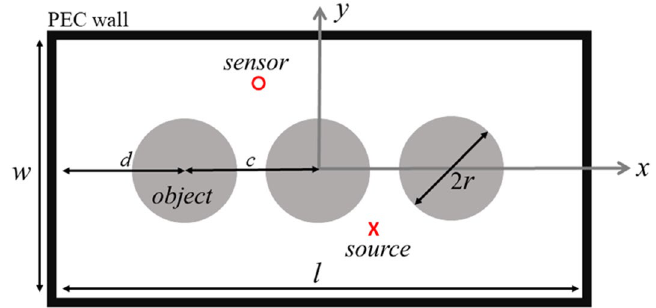
Figure 1. Geometry of the 2D power transformer model, including a metallic tank (thick black PEC frame), source, sensor, and three windings. The tank is symmetric along the x and y axes. d = 250 mm, c = 250 mm, and r = 100 mm. w = 0.5 m and l = 1